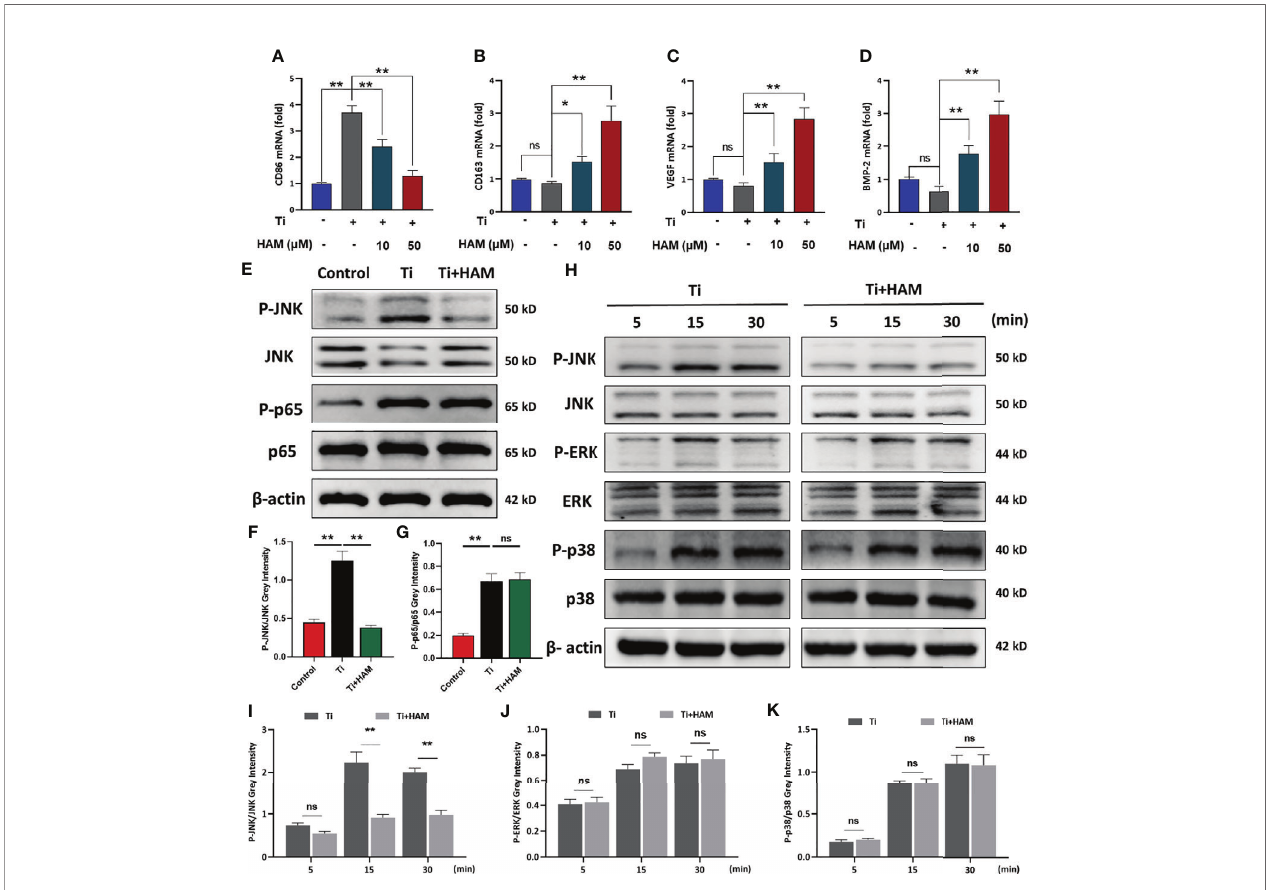
FIGURE 6 | Harmine suppressed Ti particle-induced activation of JNK signaling in vitro . RT-PCR results for (A) M1 marker CD86, (B) M2 marker CD163, (C) VEGF and (D) BMP-2. (E) JNK, P-JNK, p65 and P-p65 protein levels, detected by western blot analysis. The relative levels of (F) P-JNK/JNK and (G) P-p65/p65. (H) JNK, P-JNK, ERK, P-ERK, p38 and P-p38 protein levels at various times, detected by western blot analysis. The relative levels of (I) P-JNK/JNK, (J) P-ERK/ERK and (K) P-p38/p38. n = 3. All data were expressed as the mean ± SD, ns, no signi fi cancel * p < 0.05, ** p <